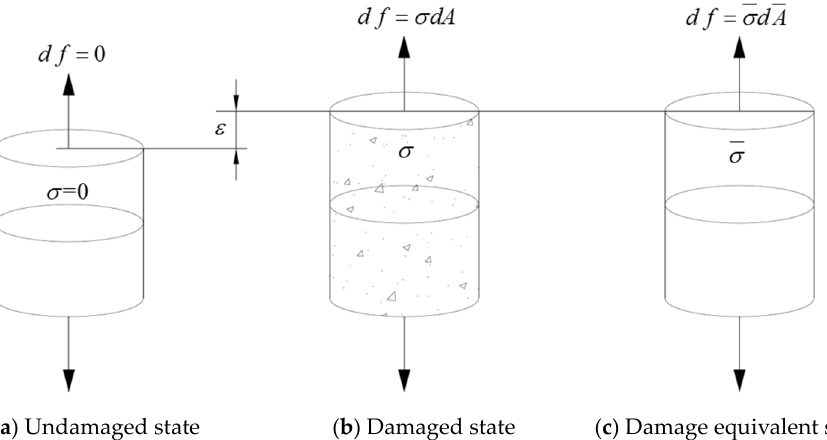
Figure 1. The constitutive relationship of materials under damage. ( df represents the force of micro-element, dA is the area of micro-element, dA is the effective area of micro-element, and ε denotes the strain.) .